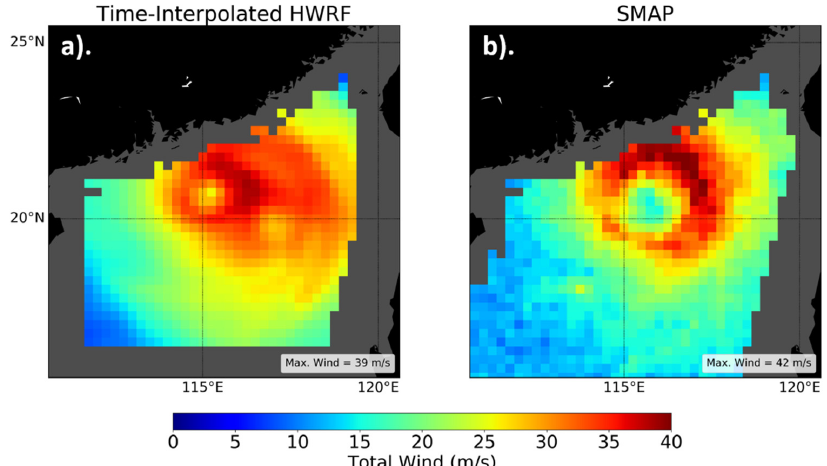
Figure 7. The resampled HWRF wind field that has been interpolated ( a ) to the time of the SMAP pass (22:34 UTC) ( b ) over Typhoon Mangkhut on 15 September 2018. An un-physical double-eye feature is clearly visible in the resampled HWRF field.